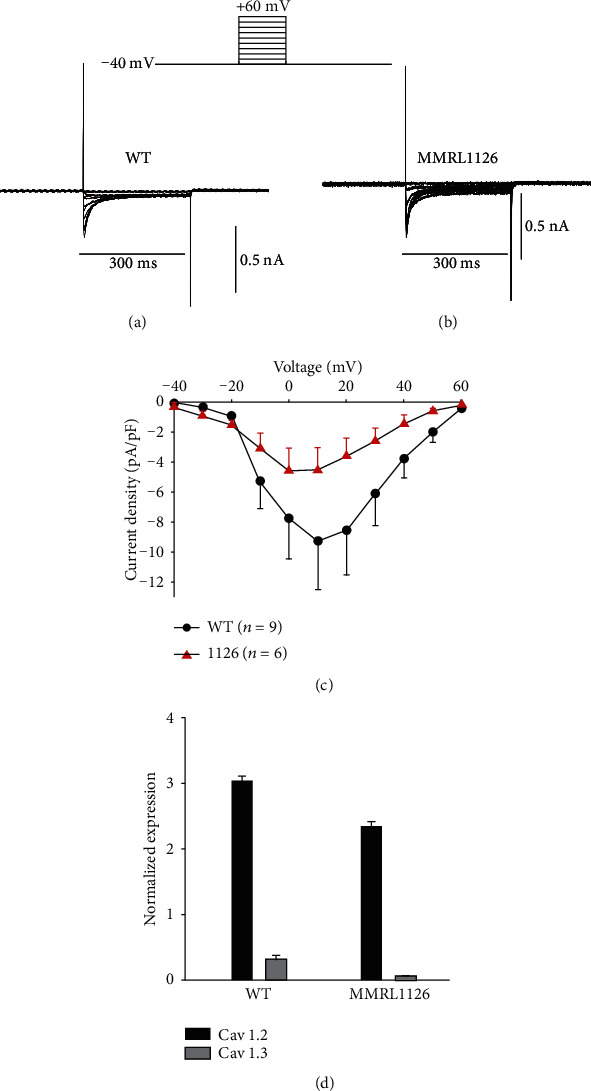
Representative traces showing ICa recorded from (a) WT and (b) MMRL1126. Ca2+ currents were recorded during a 300 ms step depolarization from -40 to +50 mV in 10 mV increments. (c) Current-voltage relationship for ICa. (d) RT-PCR showing a reduction of Cav1.2 and Cav1.3 message in MMRL1126.